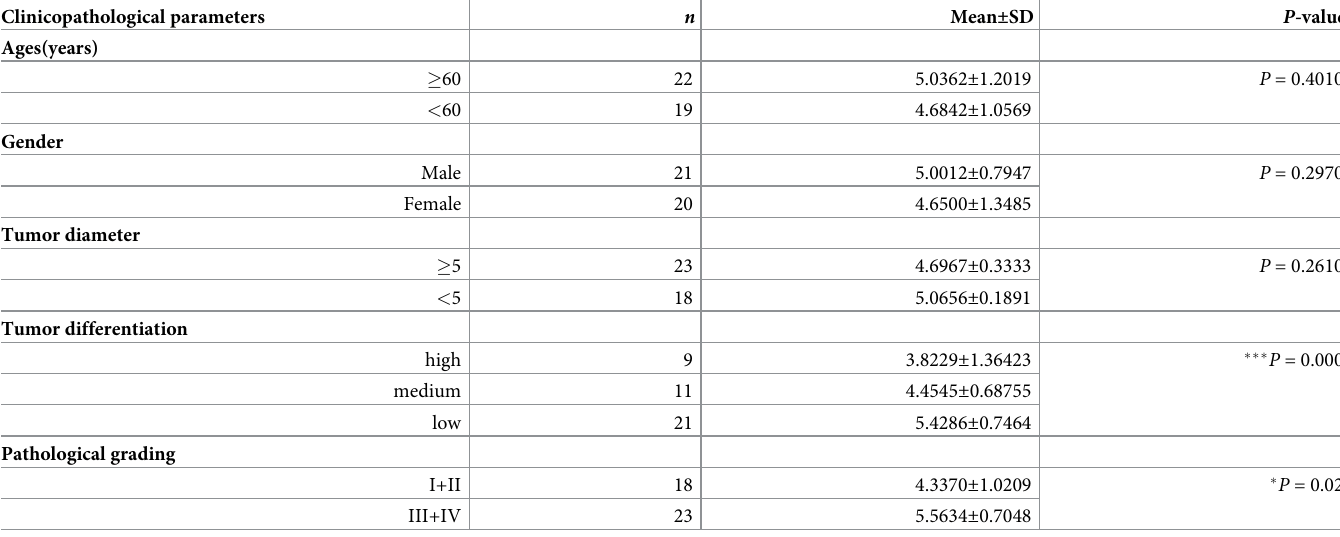
To characterize the functional role of COPB2 in RKO and HCT116 cell proliferation, CCK8 assays and Celigo cell counting assays were performed. The CCK8 assays demonstrated that, compared with that in the parental cells and shCtrl-treated cells, the proliferation ability was decreased in shCOPB2-treated cells after culturing for 2 or 4 days ( �� P < 0.01 or ��� P < 0.001, Fig 4A and 4B). Celigo cell counting assays also demonstrated that the proliferation of cells treated with shCOPB2 was significantly inhibited 2 or 3 days after infection compared with that of control cells (Fig 4C–4F). These results indicate that COPB2 knockdown inhibited the proliferation of RKO and HCT116 cells. Table 2. Relationship between COPB2 expression and clinicopathological parameters by IHC staining. Clinicopathological